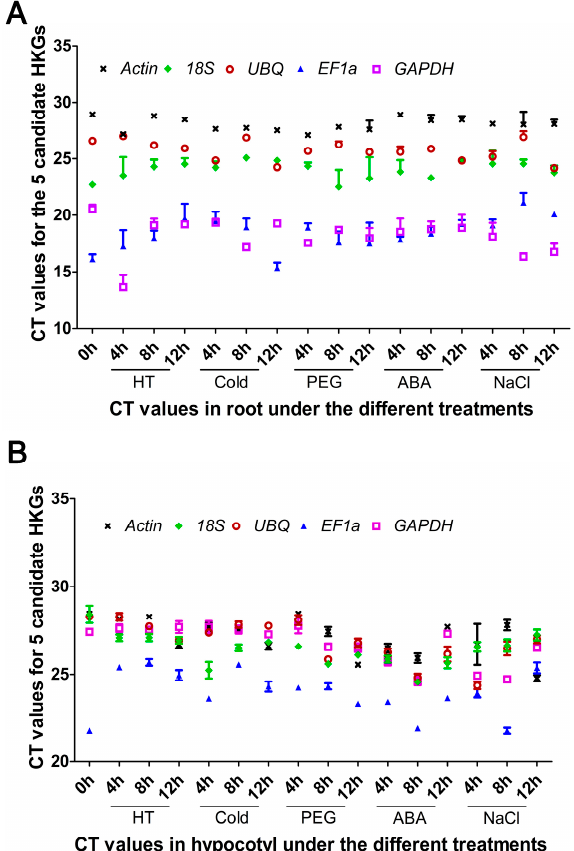
Figure 2. Transcription abundance levels of HKGs tested in Chinese fir root ( A ) and cotyledon ( B ), shown as C t mean value ± Standard Deviation (SD). Abbreviations: HT: High Temperature treatment; Cold: Cold treatment; ABA: Abscisic Acid treatment; NaCl: Sodium Chloride treatment; PEG: Polyethylene Glycol treatment